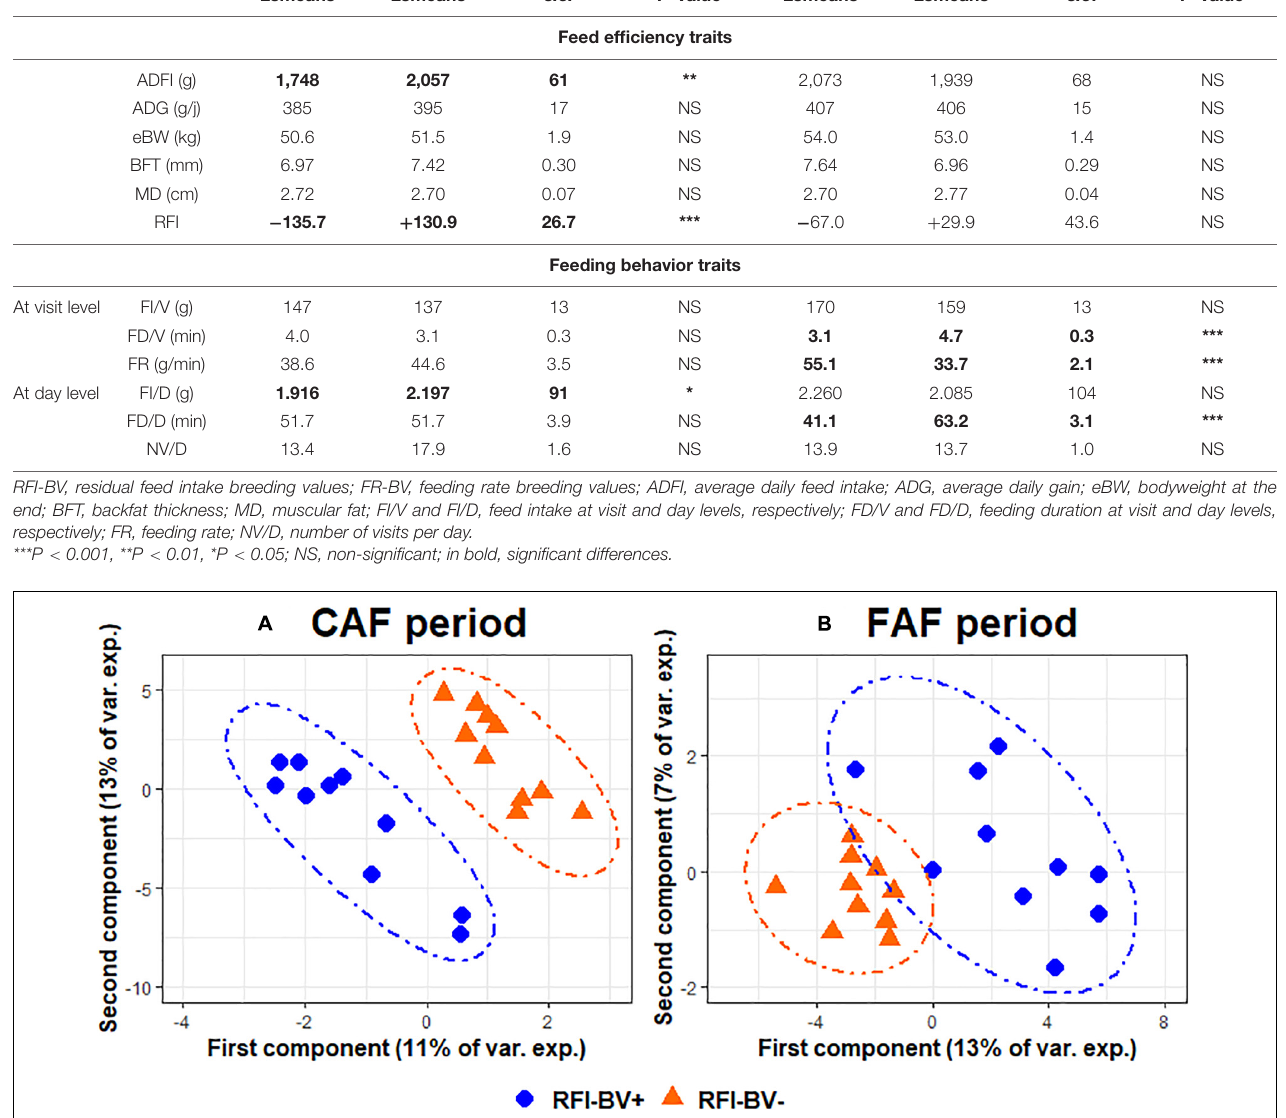
RFI-BV − RFI-BV + (efficient) (inefficient) s.e.